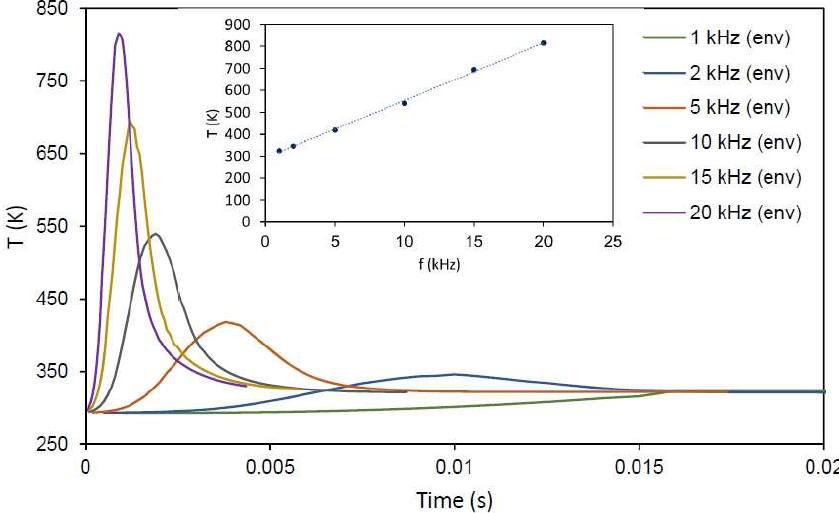
Figure 9. Envelope of the cool-down temperature depending on the repetition rate. Inset shows the linear behavior of the maximum cool-down temperature with frequency. Lines are visual guides.